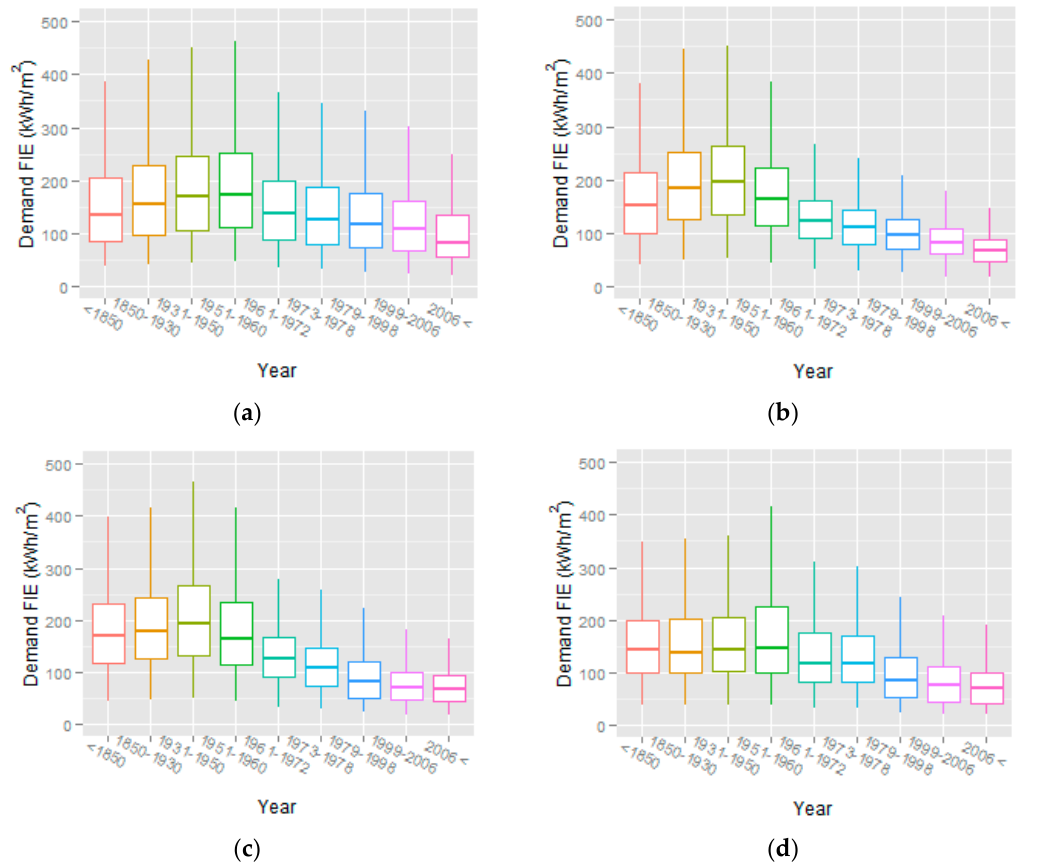
Figure 1. Heat demands in building category ( a ) 110 (Farmhouse and agricultural holding); ( b ) 120 (Detached single-family house); ( c ) 130 (Terrace, linked or double house (horizontal separation between units)); ( d ) 140 (A building of flats (A house for multiple families including two family housing (Vertical separation between units))).